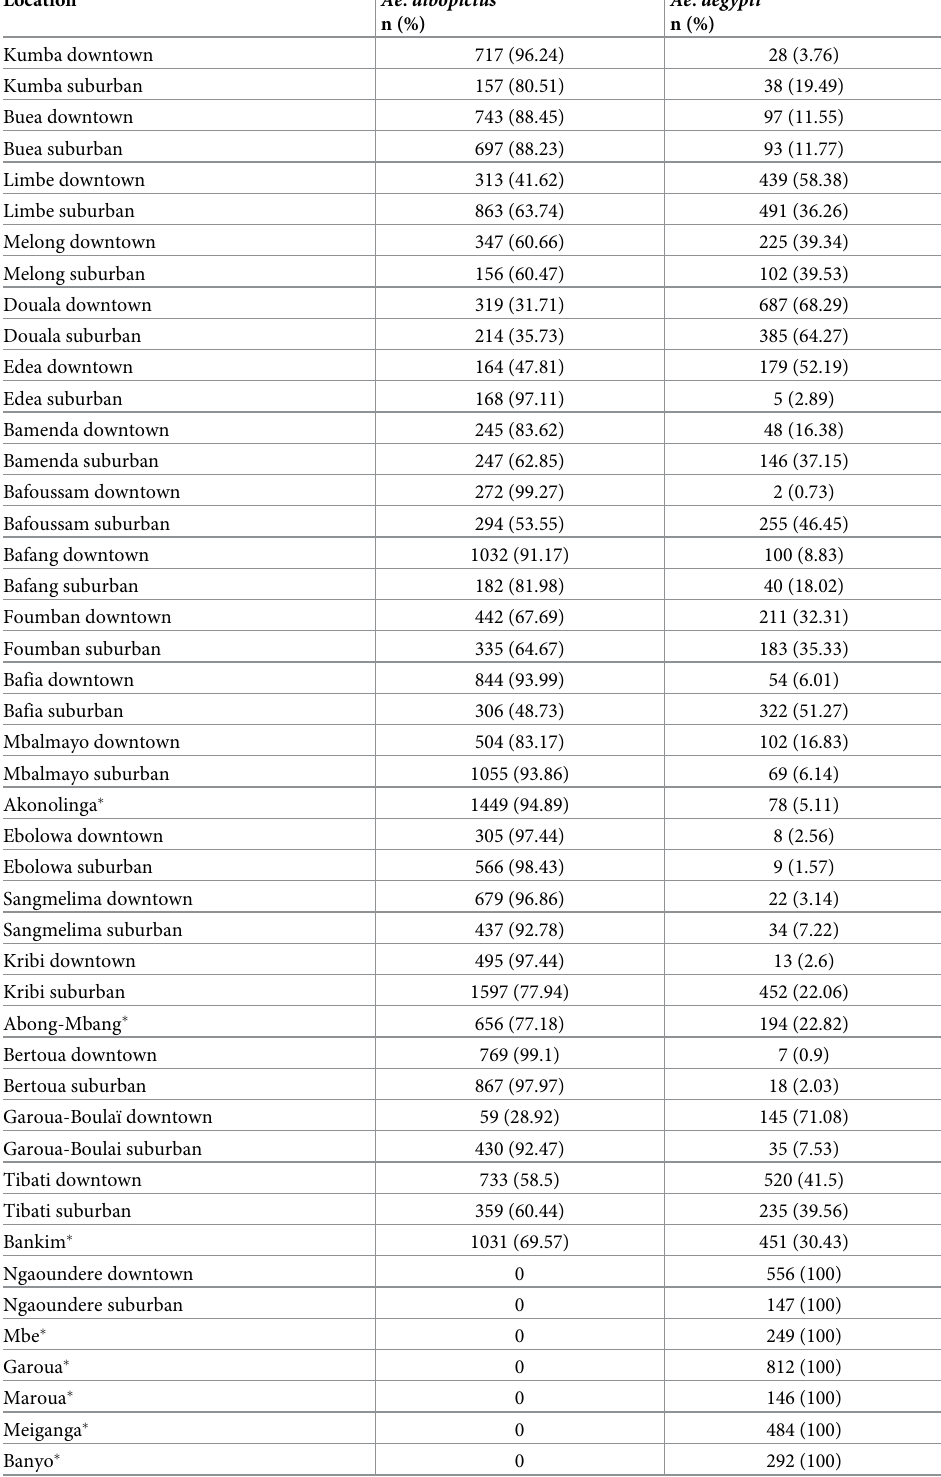
Table 3. Relative abundance of Ae . albopictus and Ae . aegypti across the prospected location in Cameroon.